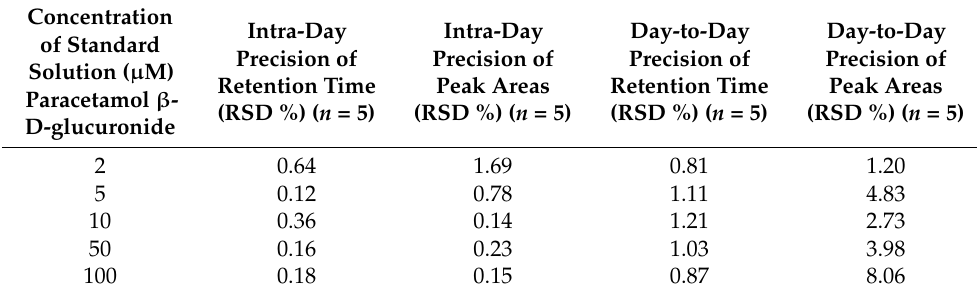
Table A2. Within-day and day-to-day precision of retention time and peak areas of paracetamol β -D-glucuronide standard solutions in drug-free intestinal